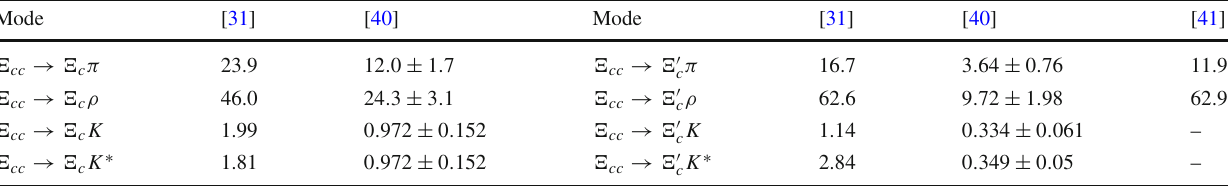
(cid:3) ) c M in references